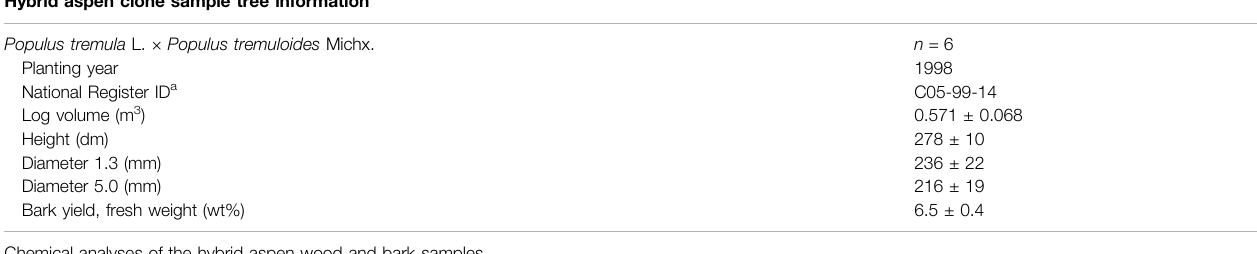
TABLE 1 | Basic information on hybrid aspen tree samples, chemical composition analysis for the wood and bark biomass fractions, number of biomass samples prepared for torrefaction, and chemical characterization of pyroligneous acids Hybrid aspen clone sample tree information Populus tremula L. × Populus tremuloides